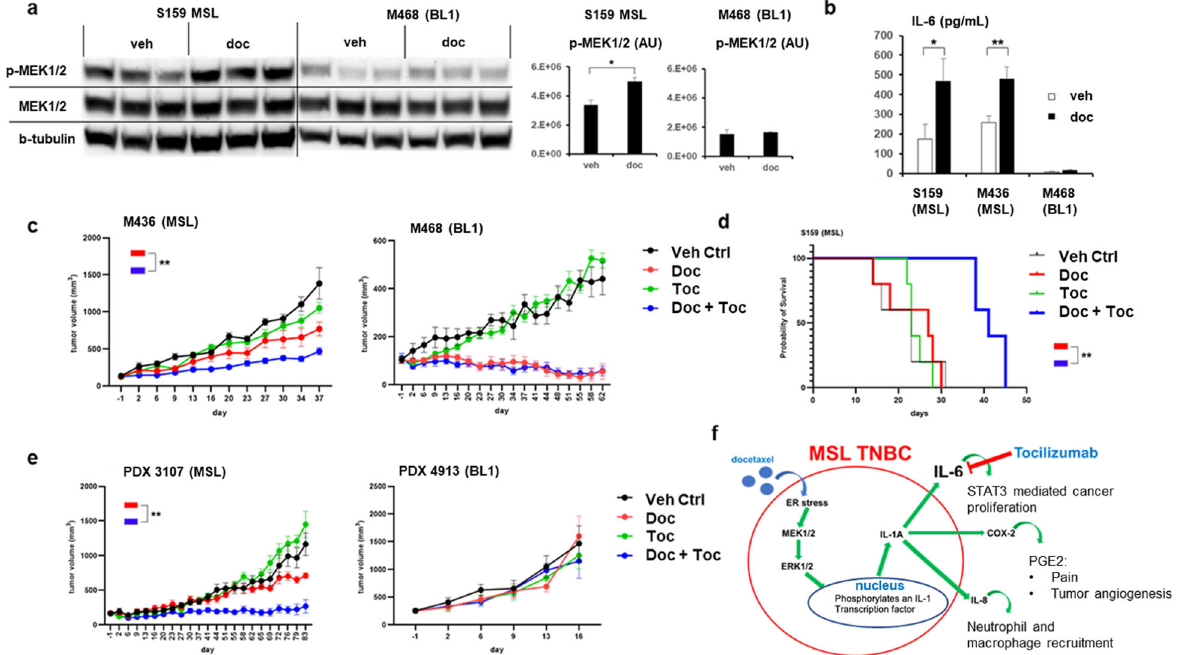
Fig. 5 Tocilizumab in combination with docetaxel provides bene fi t against MSL TNBCs in vivo, and not against BL1 TNBCs. a Female NSGs were implanted with human TNBC cell lines and treated for 2 days with vehicle (veh) or docetaxel (doc) 20 mg/kg. WB was performed from primary tumor and shown are average ± SEM densitometry ( n = 3 pairs for both cell line xenografts). The six indicated MSL samples were performed on one membrane and the six BL1 samples were performed on a separate membrane. b Female NSGs were implanted with human TNBC cell lines and treated with veh or doc (20 mg/kg). Two days later, serum was collected and human IL-6 average ± SEM was determined by ELISA. S159 = 10 pairs, M436 = 8 pairs, M468 = 6 pairs. a , b Signi fi cance was determined by unpaired t -test. c Shown are average